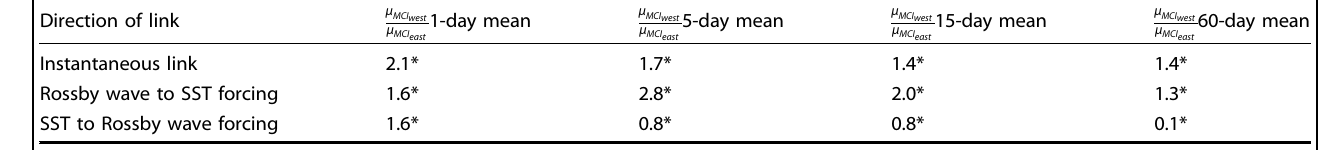
Table 1. Comparing SST-RW coupling strength in summer by the mean ratio of the Momentary Conditional Information (MCI) values ( μ MCIwest / μ MCIeast